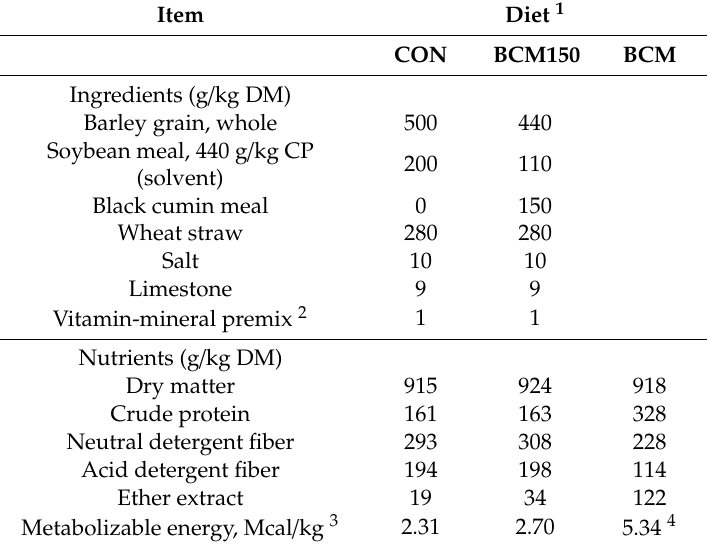
Table 1. Ingredients and chemical composition of diets-containing black cumin meal (BCM) fed to Awassi